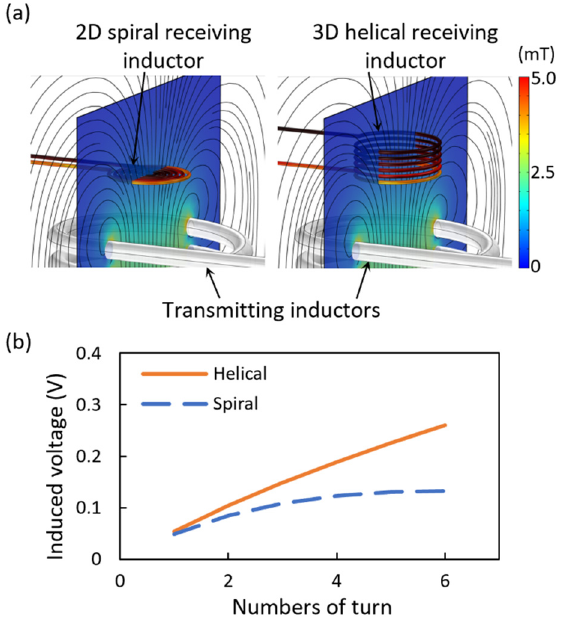
Figure 3. Comparison between a two-dimensional spiral and a three-dimensional helical receiving inductor: ( a ) The magnetic flux density around the inductors is displayed on the surface containing the center of the inductors, and the pattern of the magnetic field is shown as the streamline. ( b ) Induced voltages according to the number of coil turns in the two-dimensional spiral and the three-dimensional helical inductor.